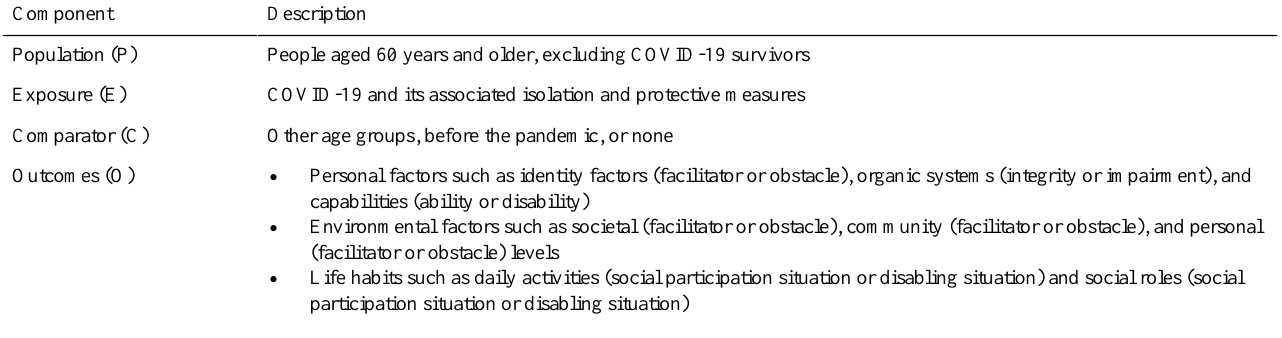
Table 1. Population, Exposure, Comparator, and Outcomes inclusion